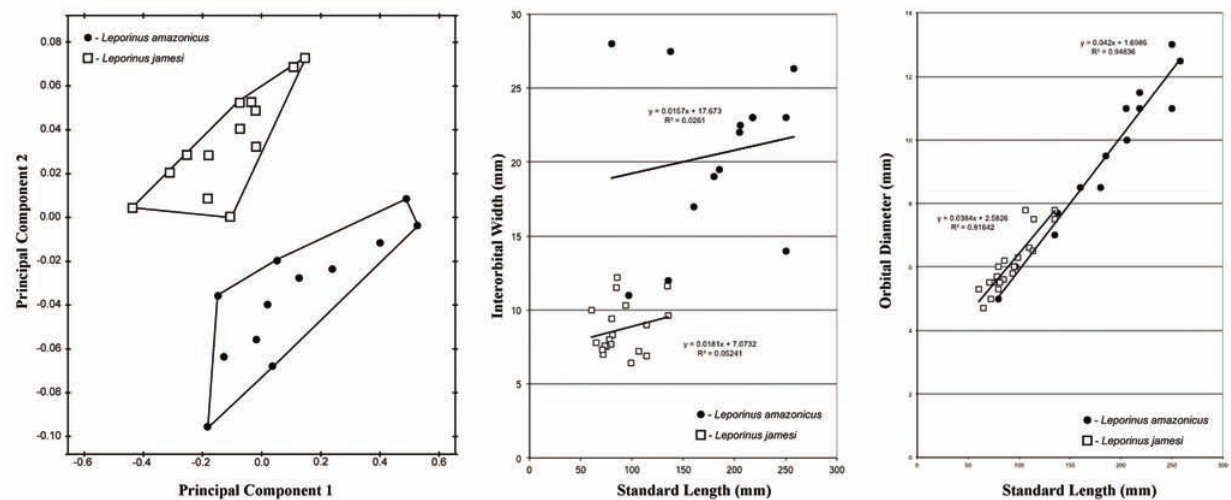
Fig. 6. Scatter plots of individual scores on first two main axes from the principal component analysis of combined samples of Leporinus jamesi (white squares) and L. amazonicus (black circles) on left; linear regression of the interorbital width (mm) vs. standard length (mm) on center; and linear regression of the orbital diameter (mm) vs. standard length (mm) on